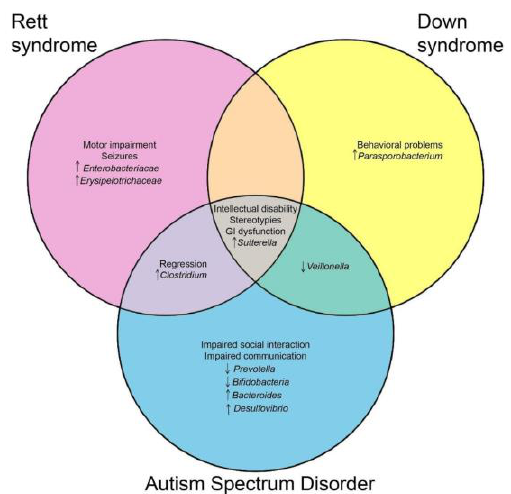
Figure 1. Venn diagram presenting the shared clinical and microbial features between Rett Syndrome, autism spectrum disorder, and down syndrome.